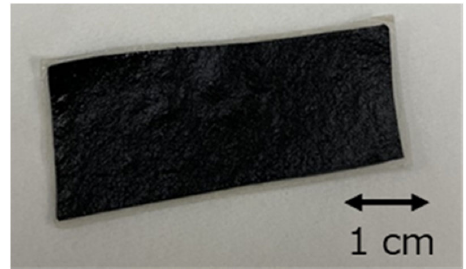
Figure 3. CNT-composite paper. Figure 3. CNT ‐ composite paper. Figure 3. CNT ‐ composite paper.